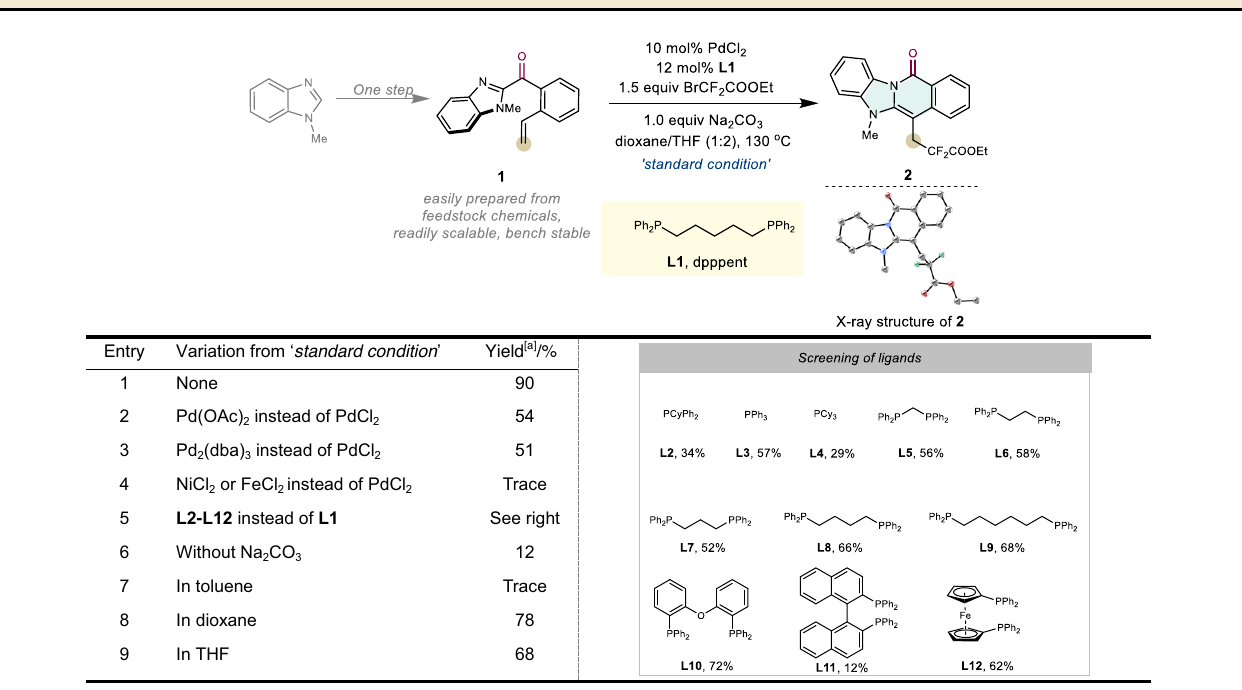
Table 1 Screening of reaction conditions.